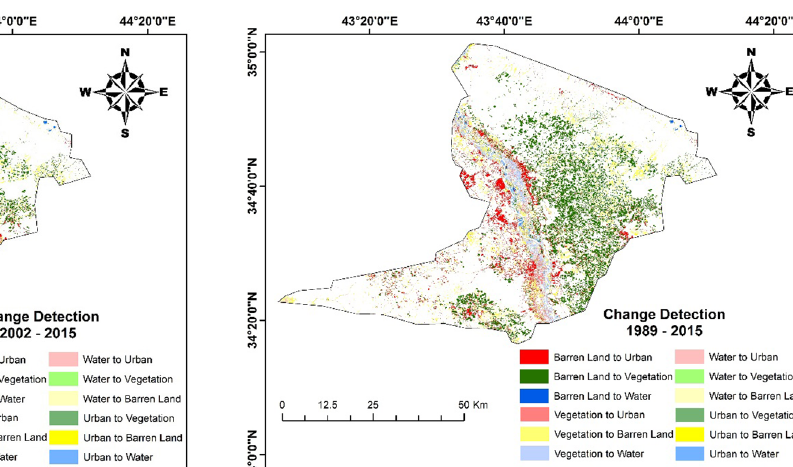
Figure 8. the spatial pattern of LULC changes during